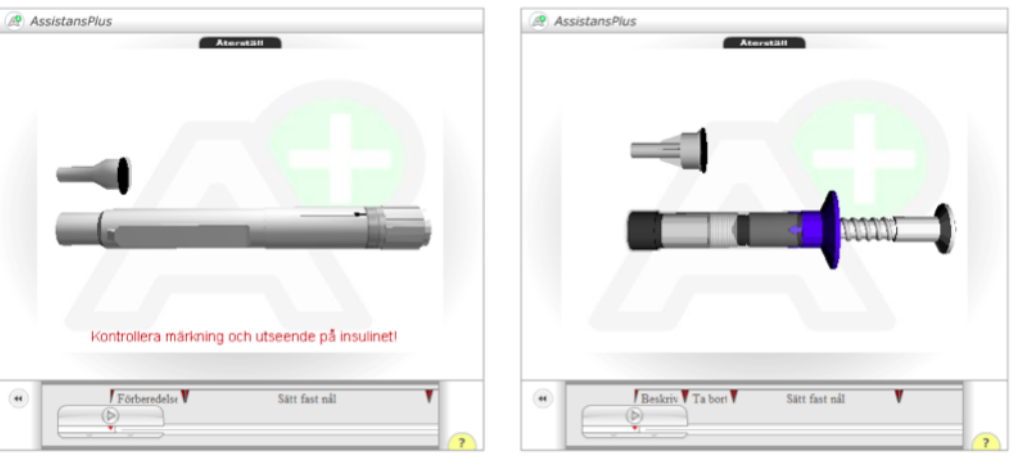
Figure 3. The 2 pharmaceutical products used in the second user study displayed using the second version of the 3-dimensional player: Lantus OptiSet (left) and Genotropin MiniQuick